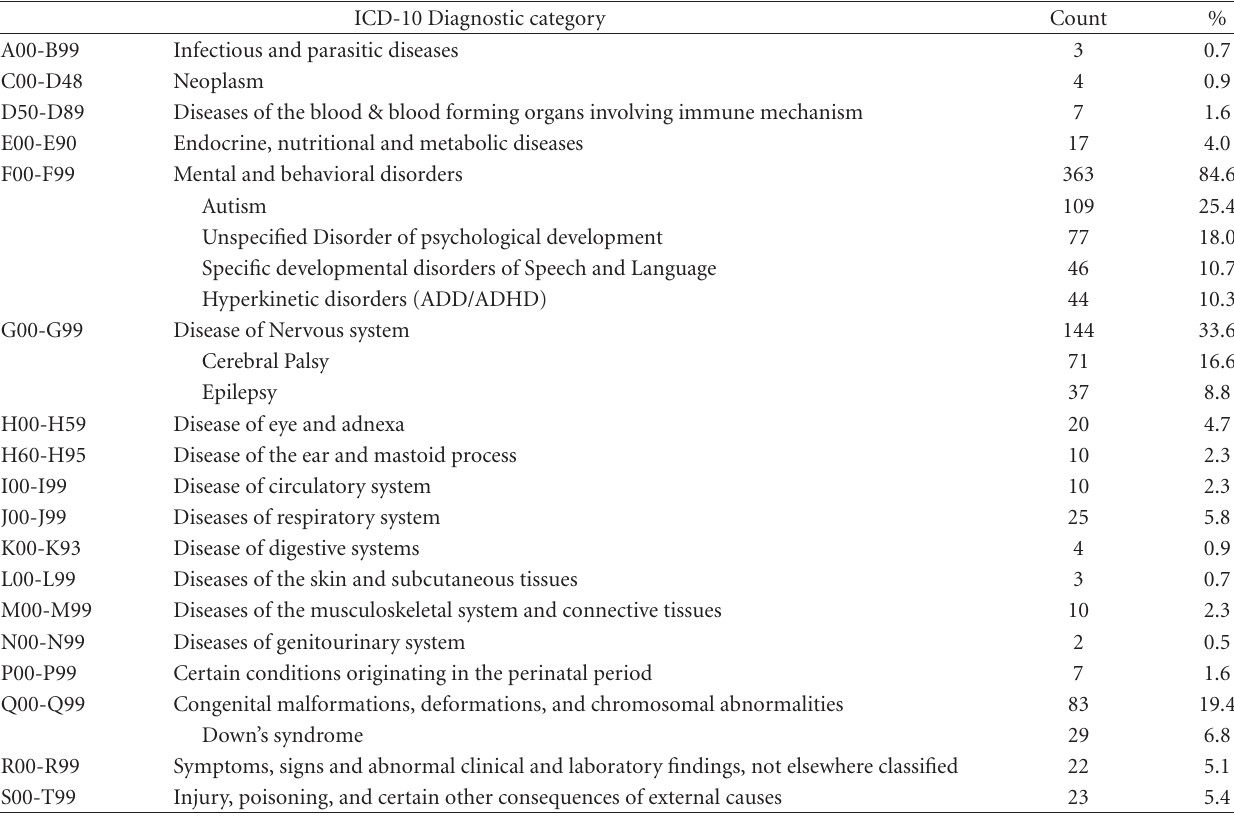
Table 2: PMK reported child diagnosis ( n =